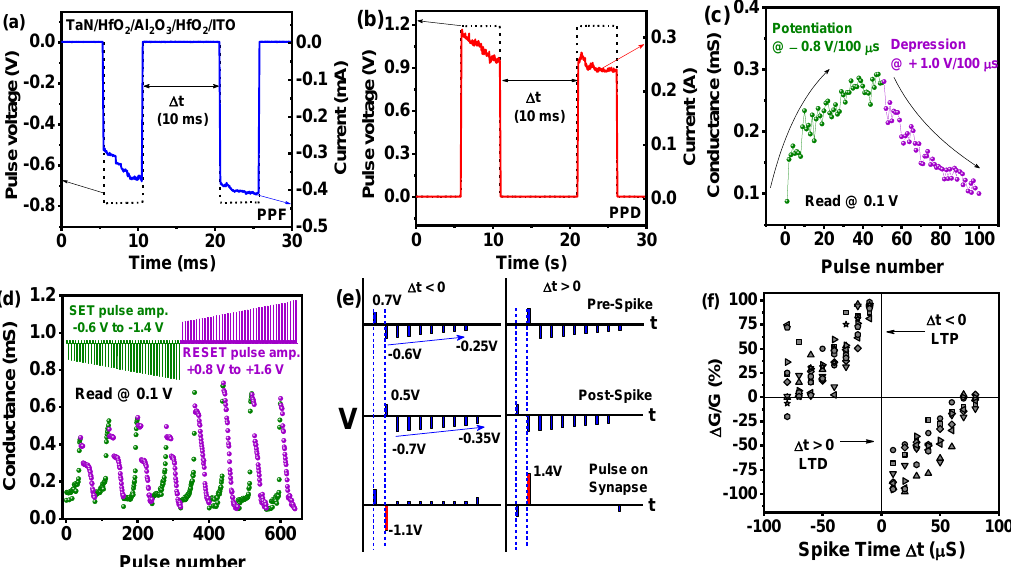
Figure 6. ( a ) Paired-pulsed facilitation and ( b ) paired-pulsed depression phenomenon of tri-layer TaN/HfO 2 /Al 2 O 3 /HfO 2 /ITO memristor device under pulse spikes of −0.8 V and +1.2 V, respectively, with a time interval of 10 ms; ( c ) pulse potentiation/depression cycle with constant pulse width of −0.8 V/100 µs and +1.0 V/100 µs, respectively, read at 0.1 V (50 pulses of potentiation and 50 pulses of depression). ( d ) Repetitive 8 cycles of gradual conductance modulation for consecutive potentiation and depression controlled by increasing step pulse and read at 0.1 V; ( e ) details of pre-pulse and post-pulse scheme design using time-division multiplexing (TDM) approach to realize spike-timing-dependent plasticity (STDP) properties; ( f ) STDP characteristics of tri-layer RRAM device shows relative synaptic weight ( ∆ W) change with respect to spiking timing ( ∆